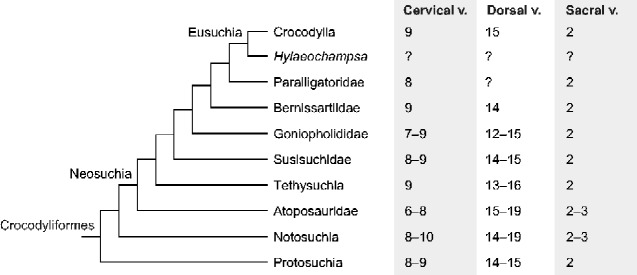
Numbers of cervical, dorsal, and sacral vertebrae in crocodyliforms. The phylogenetic relationships are based on Wilberg (2015) and Wilberg et al. (2019), supplemented by Turner (2015) and Tennant et al. (2016). Note that phylogenetic positions of many clades are still under debate (Puértolas-Pascual et al. 2020). Literature for vertebral counts of each clade: Paralligatoridae (Wu, Cheng, et al. 2001; Pol et al. 2009); Bernissartiidae (Norell and Clark 1990); Goniopholididae (Wu et al. 1996; Lauprasert et al. 2007; Erickson 2016; Martin et al. 2016; GMNH-PV0000229); Susisuchidae (Salisbury et al. 2003, 2006; Figueiredo et al. 2011); Tethysuchia (Troxell 1925b; Storrs 1986; Langston 1995; Wu, Russell, et al. 2001; Jouve and Schwarz 2004; Jouve et al. 2006; Schwarz et al. 2006); Atoposauridae (Wellnhofer 1971; Buscalioni and Sanz 1990; Michard et al. 1990; Storrs and Efimov 2000; Tennant et al. 2016); Notosuchia (Pol 2005; Turner 2006; Fiorelli and Calvo 2008; Sereno and Larsson 2009; Georgi and Krause 2010; Nascimento and Zaher 2010; O’Connor et al. 2010; Nobre and de Souza Carvalho 2013; Leardi et al. 2015; Martinelli et al. 2018); Protosuchia (Colbert and Mook 1951; Li 1985; Wu et al. 1994; Peng 1996; Osmólska et al. 1997; Pol and Norell 2004; Peng and Shu 2005). See Supplementary data, Table S3 for vertebral counts for each species.